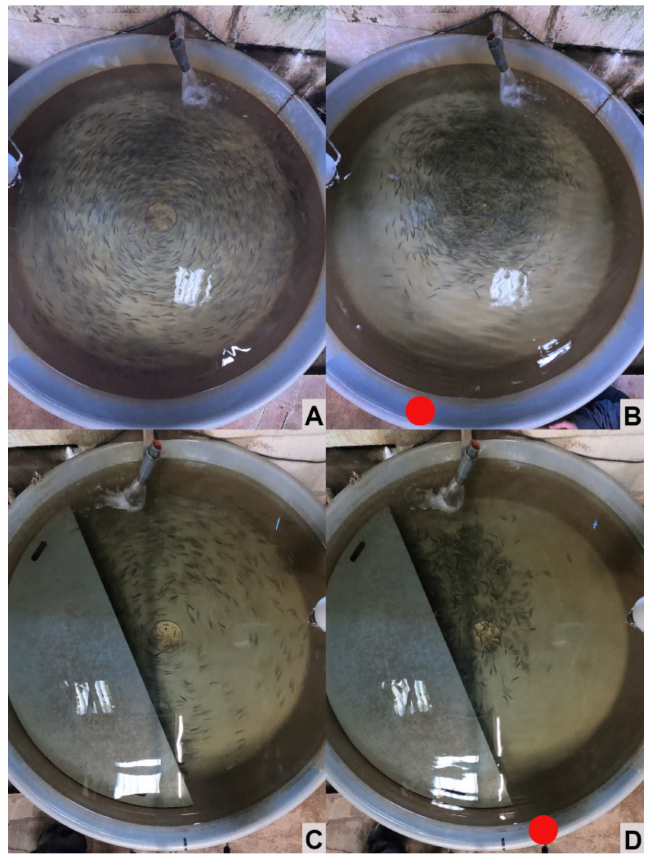
Figure 7. Representative zenithal pictures showing the usual swimming behavior of the rainbow trout ( Oncorhynchus mykiss ) fingerlings in the control ( A , B ) and sheltered tanks ( C , D ). Left panels ( A , C ) show fish swimming in undisturbed conditions, while panels ( B , D ) show the typical response of the fish just after disturbance (knocking on the tank wall): Fish tended to get away from the tank walls and group together, and this behavior appeared similar for both control and sheltered tanks. Red circles in ( B , D ) indicate the knocking spot. See the main text for more